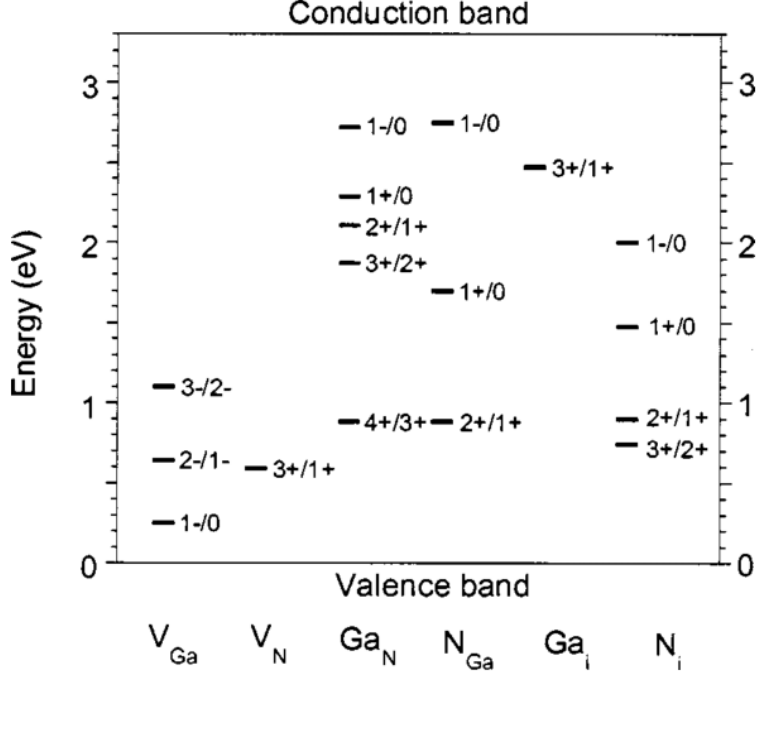
Figure 5. Transition levels for native point defects in GaN. Defects in semiconductors and insulators can occur in different charge states. For each position of the Fermi level, one particular charge state has the lowest energy for a given defect. The Fermi-level positions at which the lowest-energy charge state changes are called transition levels or ionization energies. For example, from this figure Ga vacancies are predicted to be in the − 3 charge state for Fermi levels greater than 1.1 eV above the valence band edge [63]. Reprinted with permission from reference 63. Copyright (2005) by the American Institute of